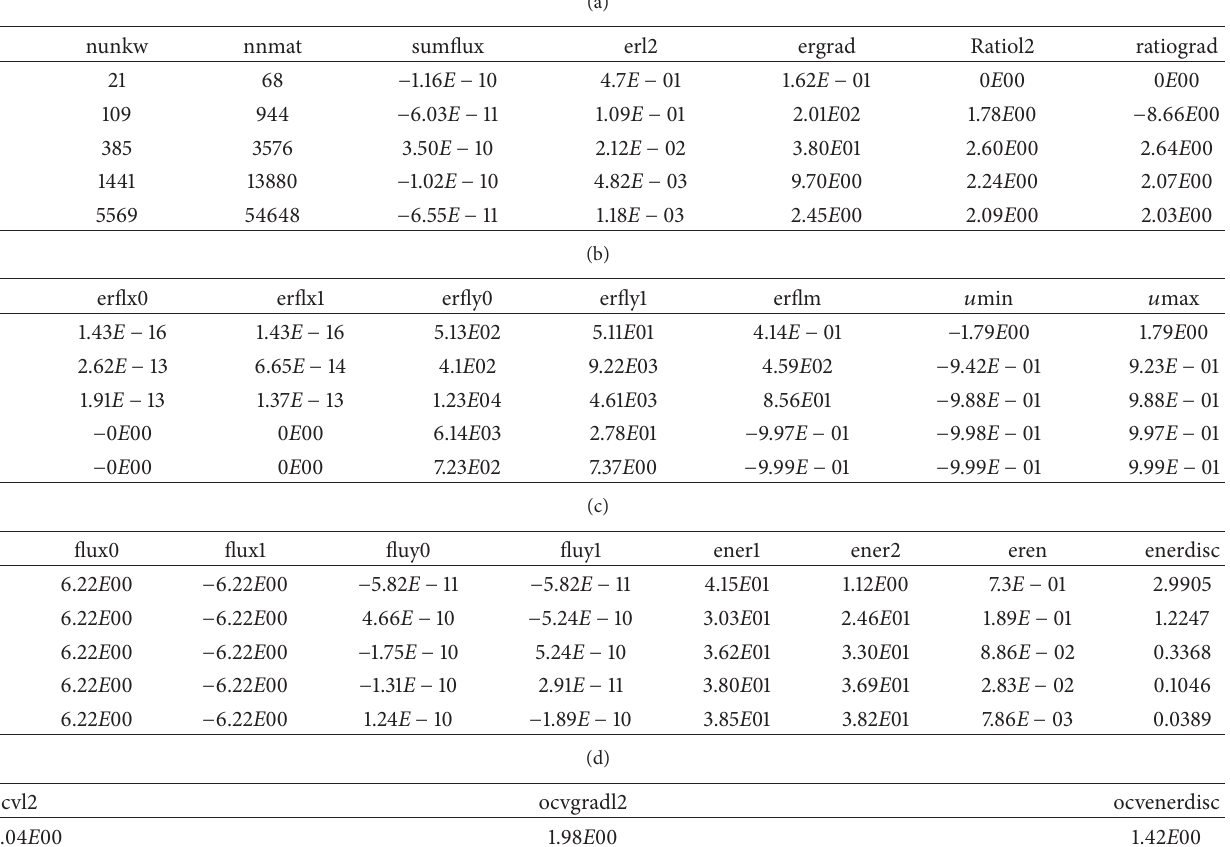
Table 1: Numerical